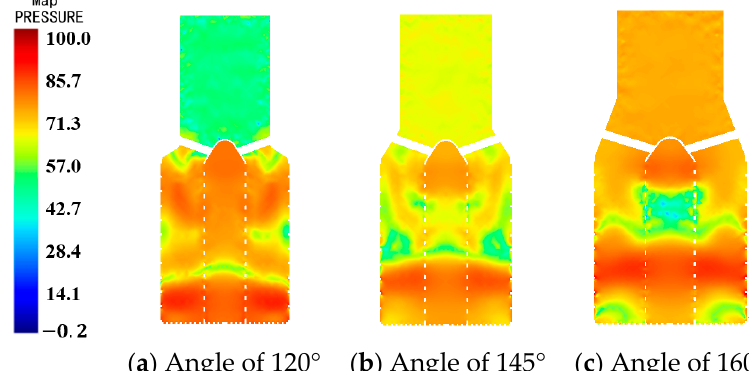
Figure 17. Sound pressure level distribution of different schemes at the first peak.